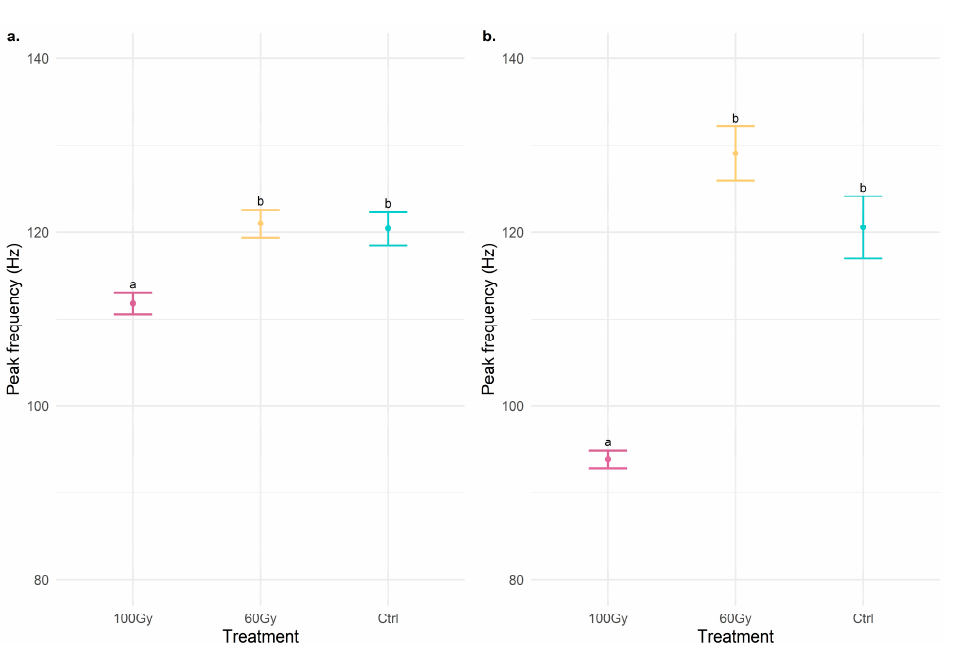
Figure 1. Dot plots with error bars of the peak frequency (Hz) of signals emitted during ( a ) the mount phase and ( b ) the mating. The dot represents the mean of peak frequency, and the error bar represents the standard error of the mean. The treatments indicated with different letters show significant di ff erences (Kruskal–Wallis test at p < 0.001).